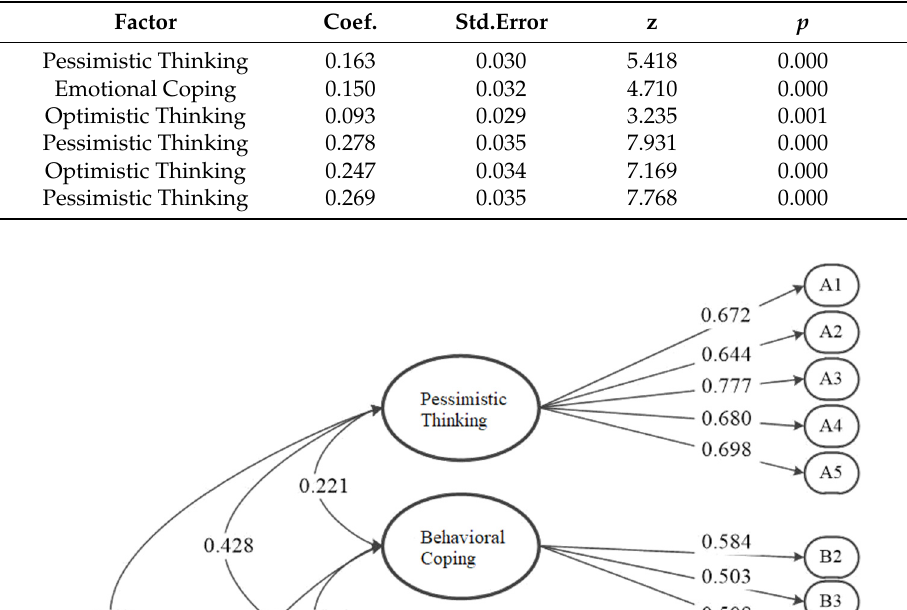
Table 11. The Factor covariance table.